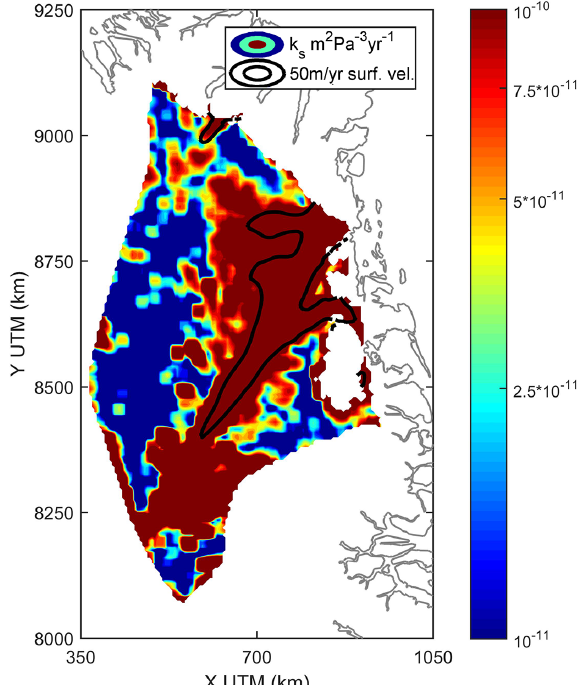
Figure 2. The result of the inversion for the sliding coefficient k s on a logarithmic scale. The contour for the 50myr − 1 surface velocity (from Joughin et al., 2010) is indicated with thick, black